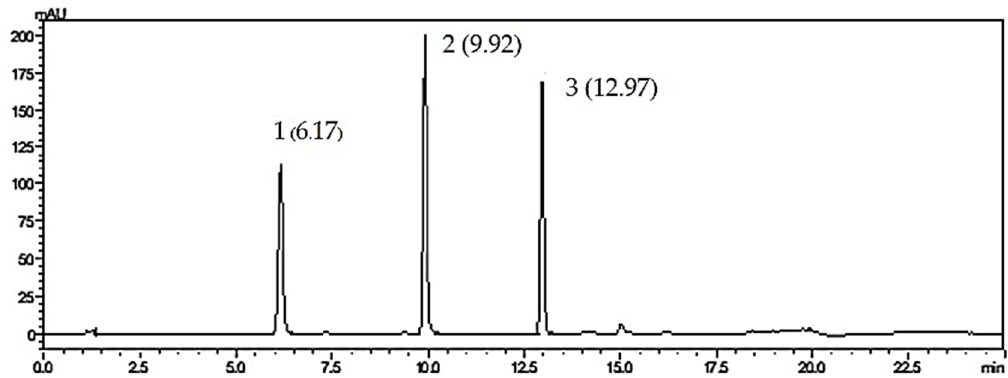
Figure 2. HPLC chromatograms of standard compounds; 1 = baicalin, 2 = baicalein, 3 = chrysin. Table 2. HPLC retention Times, UV Spectra, Previous Reported MS Data and Chemical Structures of Chemical Compounds in O. indicum Extracts and Fractions. Peak No. Rt (min.)